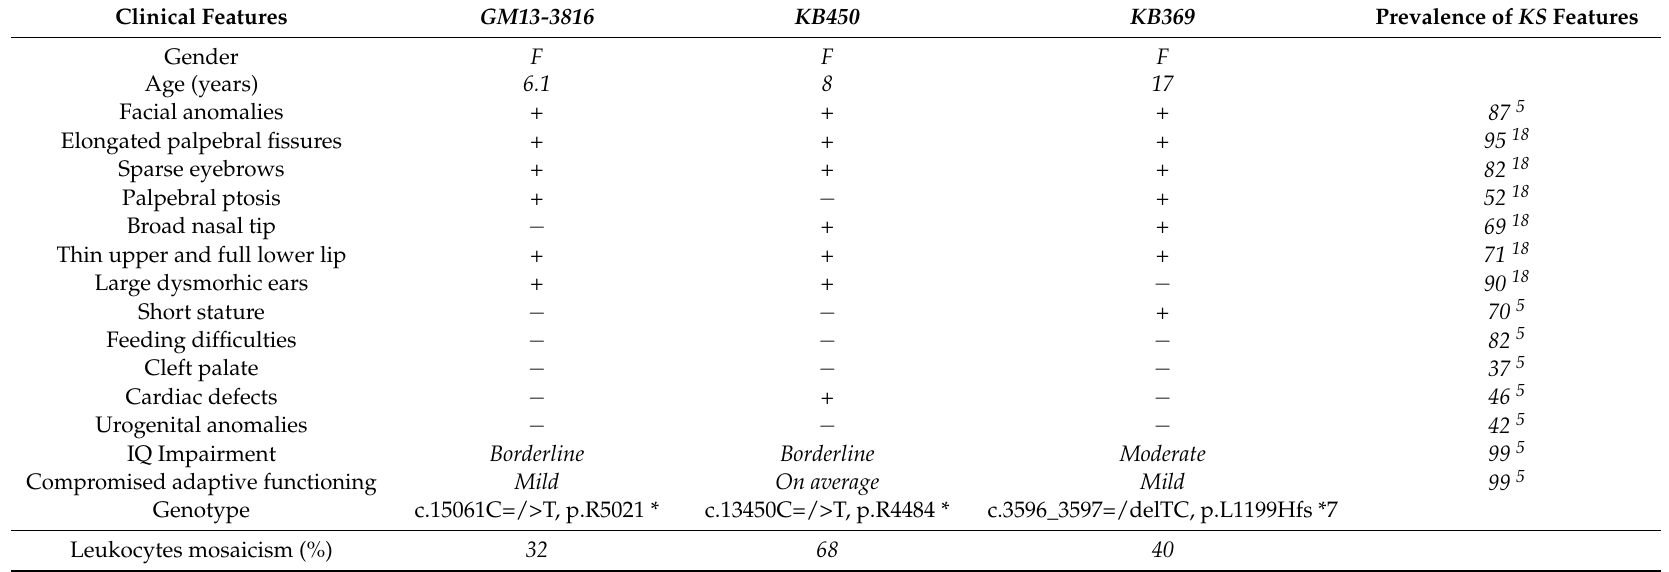
Table 1. Clinical features of patients with mosaic KMT2D